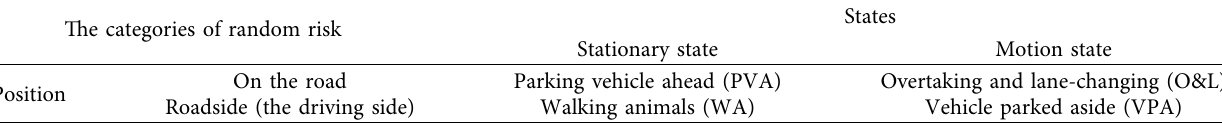
Table 2: The classification of random risk points on prairie highways.